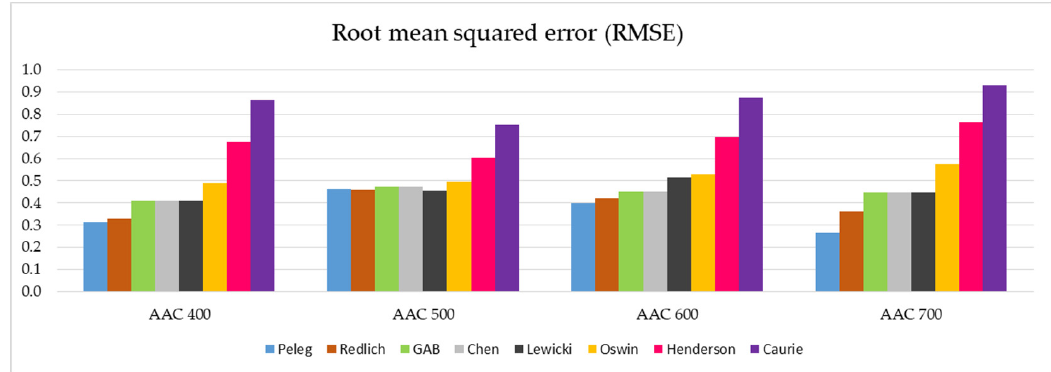
Figure 8. Graphical representation of the RMSE values determined for the eight models analyzed and the four AAC density classes tested (data on individual values of RMSE are presented in Table 5).